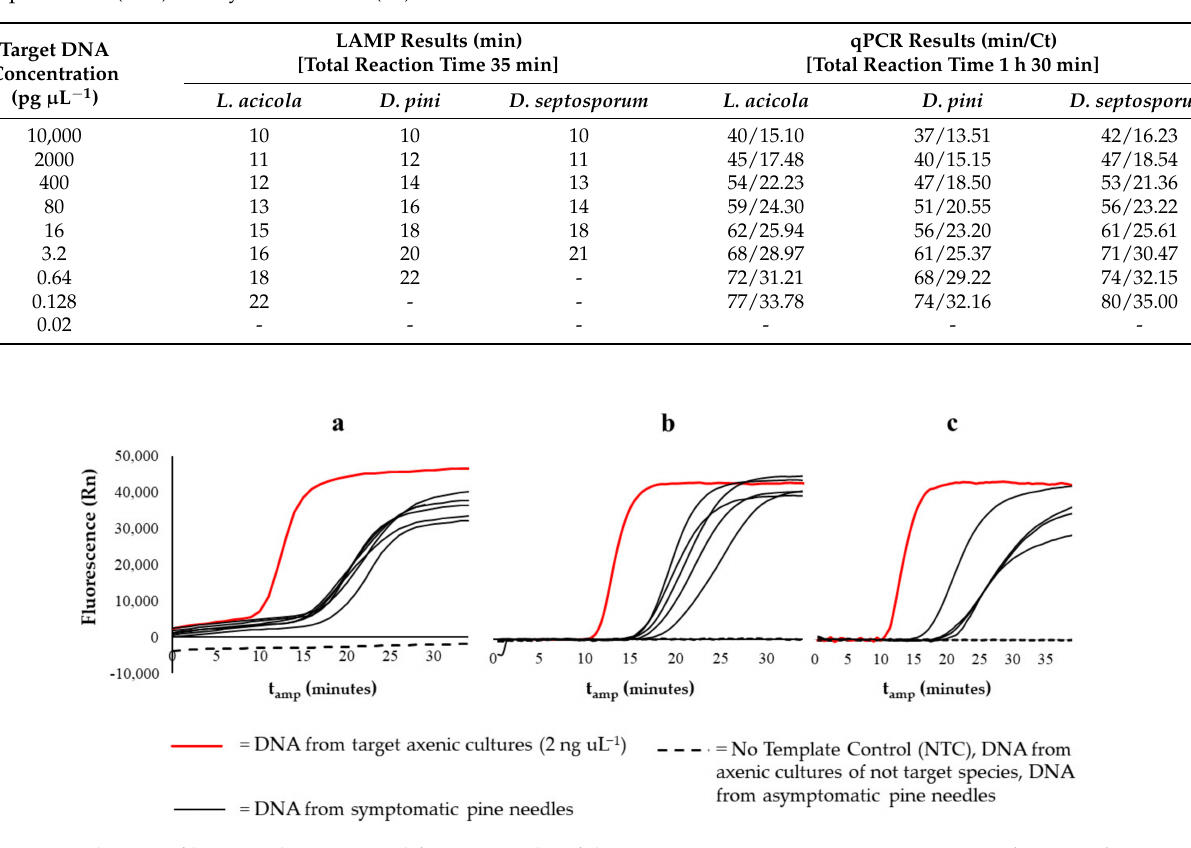
Figure 1. Selection of kinetics showing amplification results of the LAMP assays targeting Lecanosticta acicola ( a ), Dothistroma pini ( b ) and D. septosporum ( c ), respectively. Red solid lines represent DNA (2 ng uL − 1 ) extracted from axenic cultures of the corresponding target species. Black solid lines represent DNA extracted from pine needles showing symptoms of the corresponding target species. Black dotted lines represent both DNA extracted from non-symptomatic pine needles and no-template